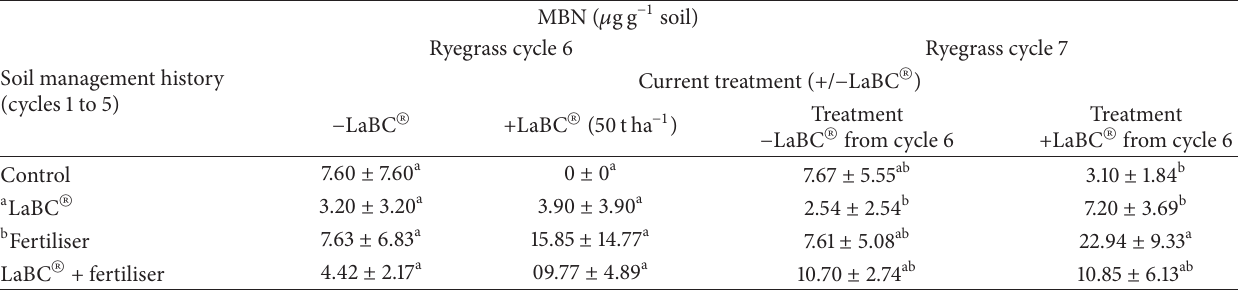
Table 9: Microbial biomass N ( 𝜇 gg − 1 soil) in ryegrass cycles 6 and 7 with reapplied LaBC Ⓡ (+/ − ) as influenced by residual effects of soil amendments from previous management